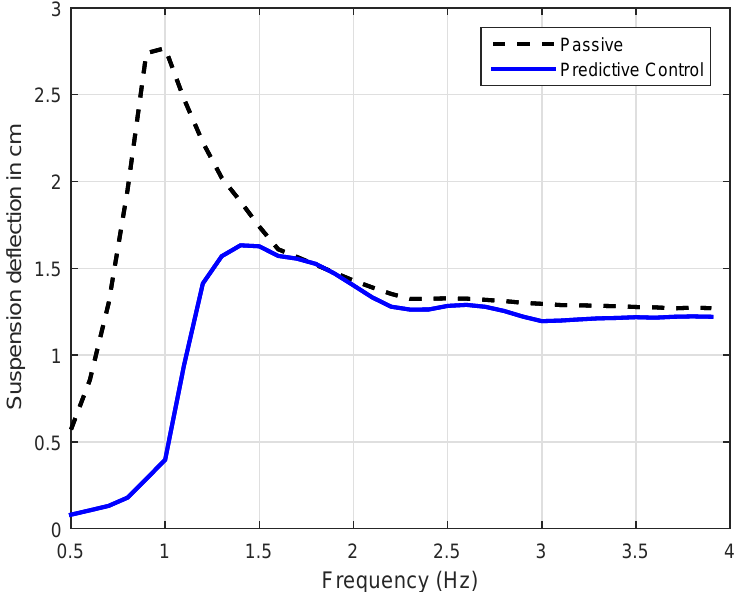
Figure 6. Suspension deflection ( z s − z us ) for the passive and predictive controlled